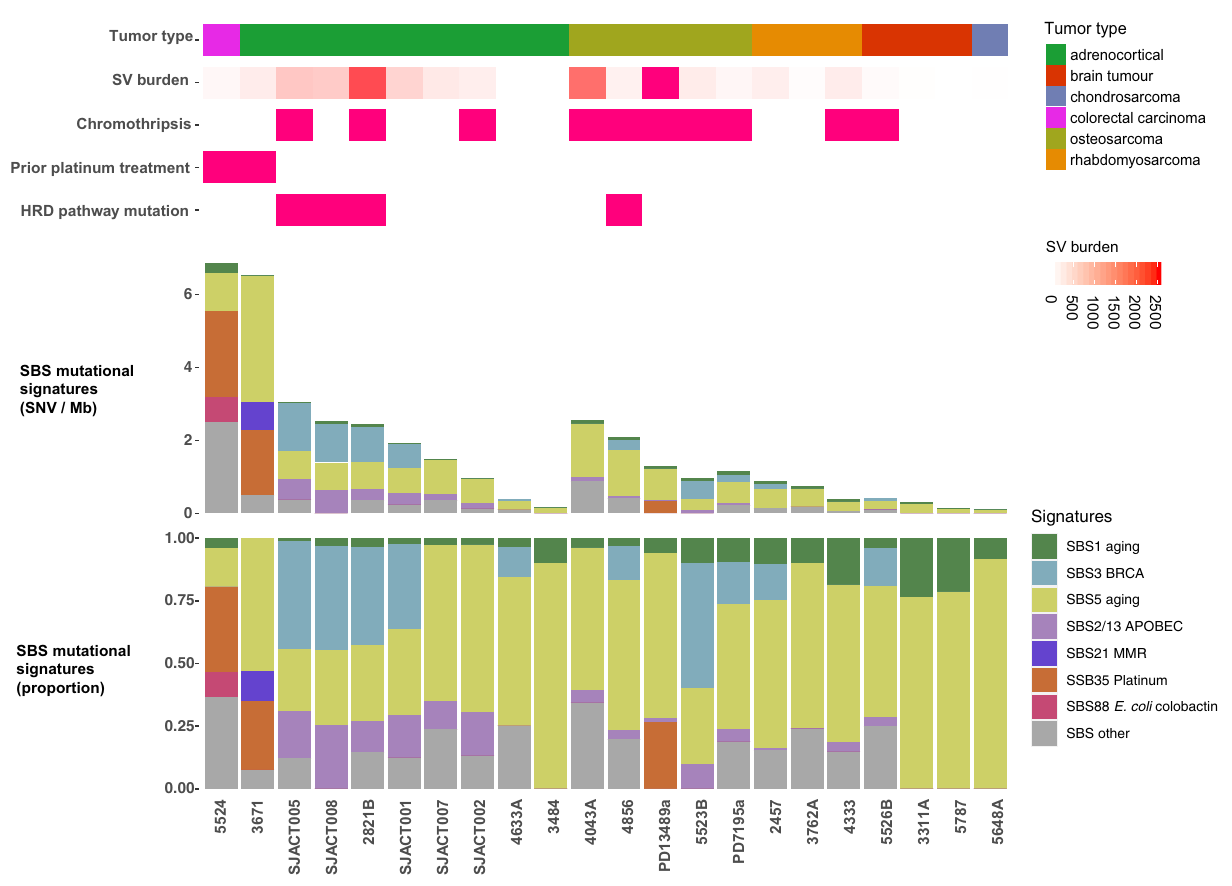
mutationalsignaturesV3.2,scaledbymutationburdenintumor(above)andscaled to proportions of 1 for each tumor (below). X-axis depicts individual tumors. Source data are provided as a Source Data fi